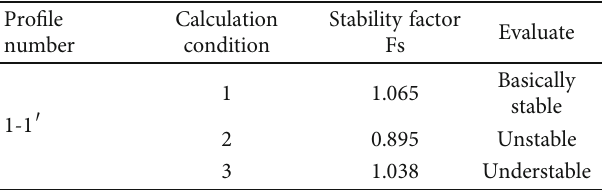
Figure 12: Calculation diagram of pro fi le above G318. Table 1: Stability calculation results of Tanziyan landslide geological